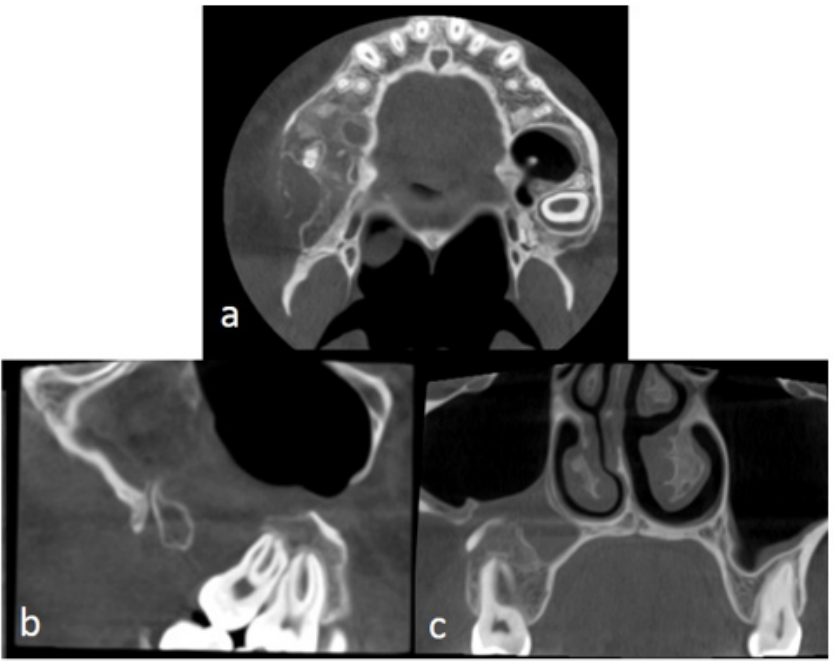
Figure 5. Multiplanar cone beam computed tomography (CBCT) slices: ( a ) axial cut showing bone formation medially; ( b , c ) sagittal and coronal cuts showing discontinuity of the antral floor and part of the anterior antral wall with oroantral communication starting distal to tooth